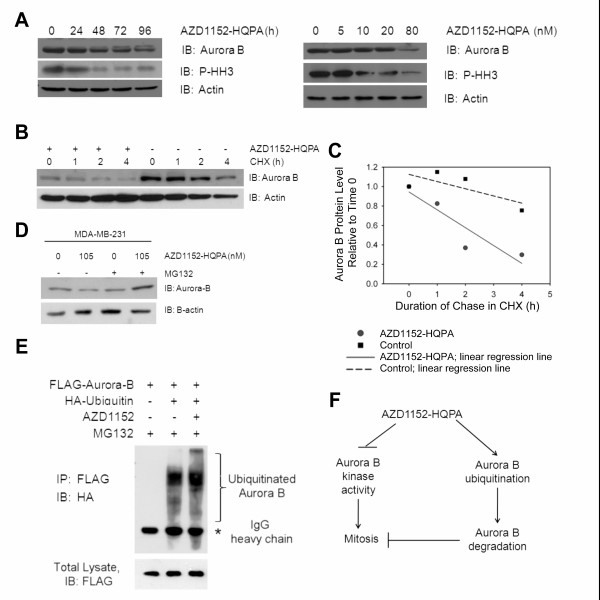
AZD1152 reduces Aurora B protein level by increasing poly-ubiquitination and degradation via the proteasome. (A) Western blots were performed for Aurora B, phospho-Histone H3 and actin levels. HER18 cells were treated with increasing duration of AZD1152 20 nM (left panel) and with increasing concentration of AZD1152 for 48 hours (right panel) as labeled. (B) HER18 cells were treated with or without 20 nM AZD1152 for 48 hours and then in the presence of cycloheximide for up to four hours. Immunoblots of Aurora B and actin are shown. (C) The integrated optical densities of the protein bands in B. The amount of Aurora B protein relative to 0 h of cycloheximide treatment was calculated for each group and corrected for gel loading differences based on actin. The relative rates of Aurora B turnover were estimated by the slope of the linear regression line for the control and AZD1152-HQPA-treated cells. (D) MDA-MB-231 cells show increased Aurora B protein levels when treated with the proteasome inhibitor MG132 and AZD1152-HQPA versus AZD1152-HQPA treatment alone. (E) AZD1152-HQPA causes increased poly-ubiquitinated Aurora B versus control. HER18 cells were transfected with the plasmids (Flag-Aurora B and HA-ubiquitin) and treated with the drugs (AZD1152-HQPA and the proteasome inhibitor MG132) as labeled above the top panel. Top panel: anti-HA immunoblot of anti-Flag-immunoprecipitates. Bottom panels: Anti-Flag immunoblot of whole cell lysates. (F) AZD1152-HQPA may disturb mitosis in at least two pathways: 1) through inhibition of Aurora B kinase activity, and 2) through increasing poly-ubiquitination and proteasomal degradation of Aurora B protein leading to decreased Aurora B function.